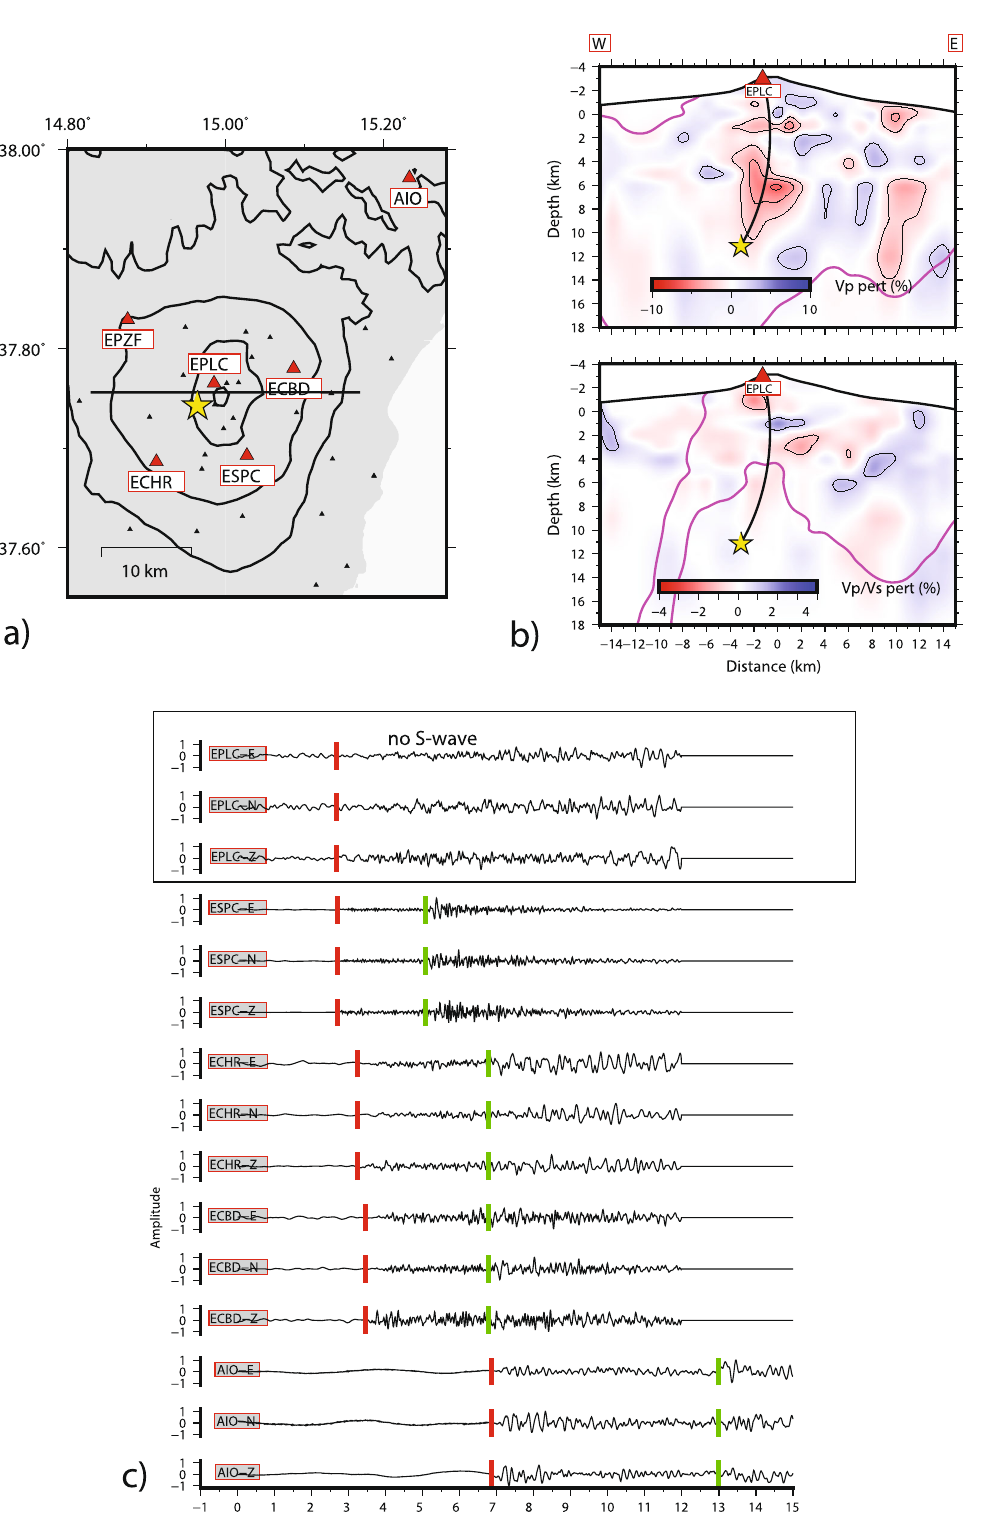
Fig. 4 Attenuation of S-wave traveling through the central low-velocity anomaly. We plot seismic waveforms for a local earthquake (04 GEN 2021, hh 08:24 (UTC), lat = 37.74, lon = 14.96, depth = 11.10 km, Ml = 1.80), yellow star in ( a ) as recorded at some stations (red triangles) shown in map ( a ). In ( c ) red and green bars on waveforms, mark the arrival times of P and S waves, respectively. The signal at station EPLC, located on top of Mt. Etna, travels through the anomalous body (seismic ray within the tomographic model in ( b ) and does not show clear S-waves ( c ), opposite to the other stations, located also at 30 km distance (AIO). The poor resolution of the S-wave model (purple line in b ) depends on this severe attenuation of signals.